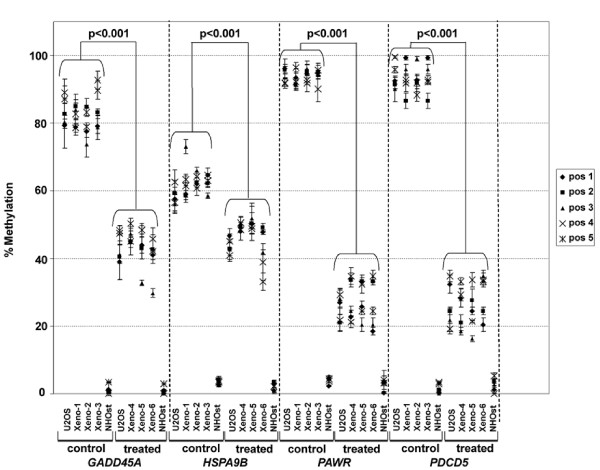
Comparison of percentage of methylation across 5 of the tested CpG positions in vitro and in vivo. Each data point is the average of methylation percentage for each CpG position in three experiments. Y-axis indicates the percentage of methylation and the samples are indicated on the x-axis. The location of CpG positions relative to the gene start site and to each other is shown in Figure 5. The results of 5 CpG positions are shown to represent the methylation percentage in the four genes across the samples. There was a significant decrease (p < 0.001) in methylation quantity for each CpG position after decitabine treatment both in vitro and in vivo for the four genes in all sample but not in the NHOst (normal human osteoblasts). p-values were calculated by comparing the percentage of methylation for each individual CpG position in control cells with the same CpG position in the treated cells using student t-test and they all resulted in p < 0.001.